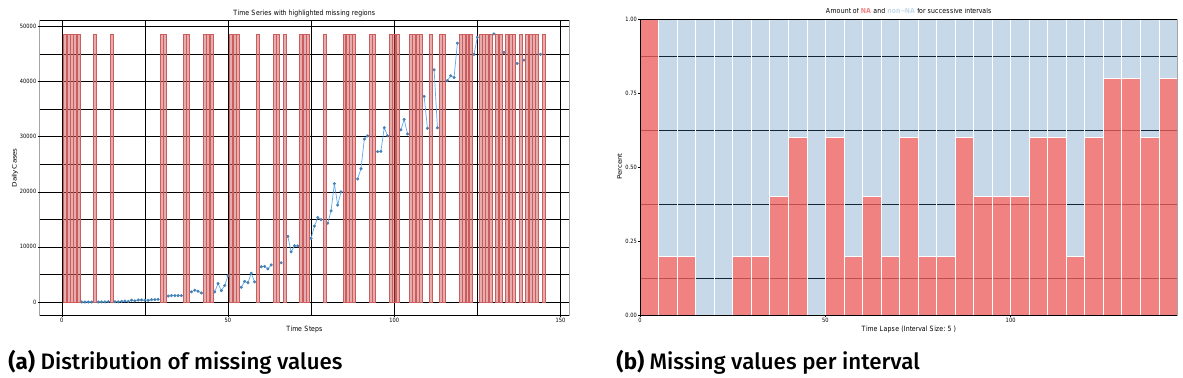
Figure 13. Characterization of the distribution and percentage of the missing data in daily cases of